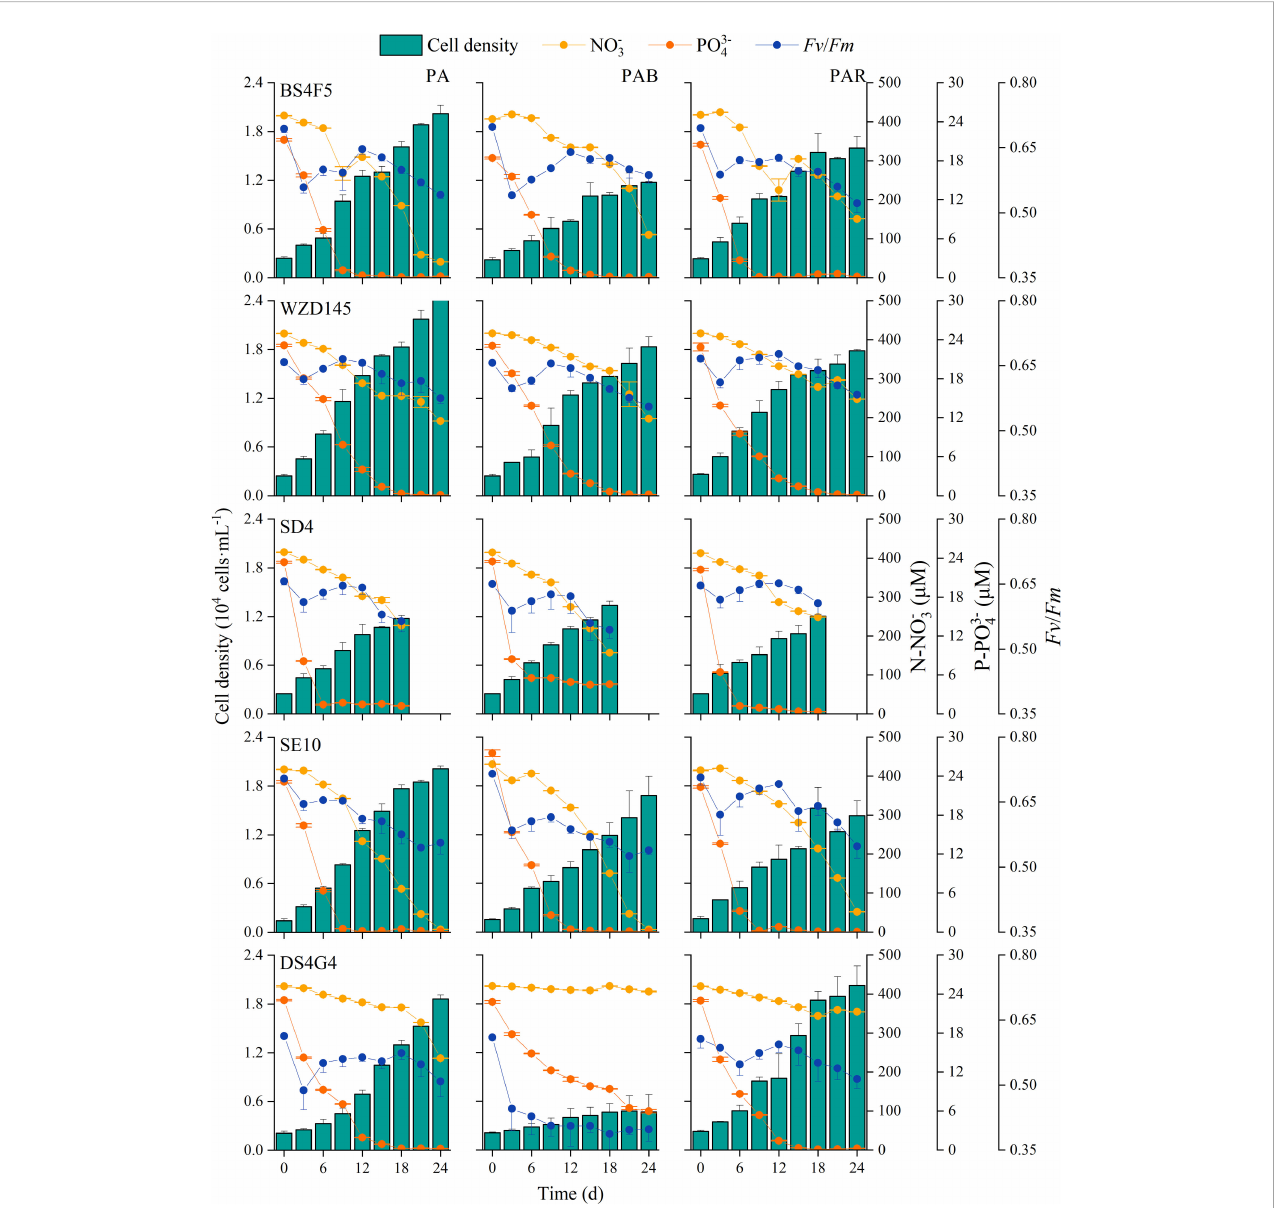
FIGURE 1 Cell growth, nutrient available and photosynthetic activity during the culture. Cell density, concentrations of nitrate and phosphate, and F v /F m of fi ve strains of P. lima complex and P. caipirignum (strain SE10) under PA, PAB and PAR treatments for 18 or 24